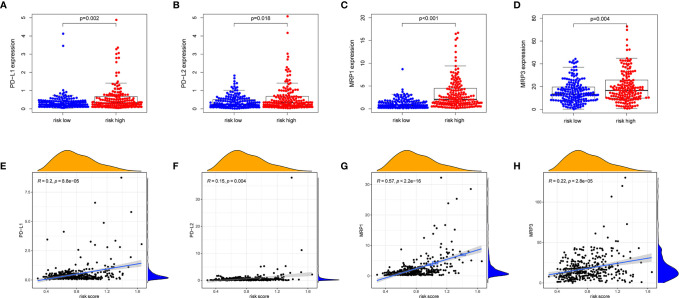
The comparison of the expression levels of PD-L1, PD-L2, MRP1 and MRP3 between different risk groups and correlation analysis between risk score and the expression levels of PD-L1, PD-L2, MRP1 and MRP3. (A, E) PD-L1. (B, F) PD-L2. (C, G) MRP1. (D, H) MRP3.